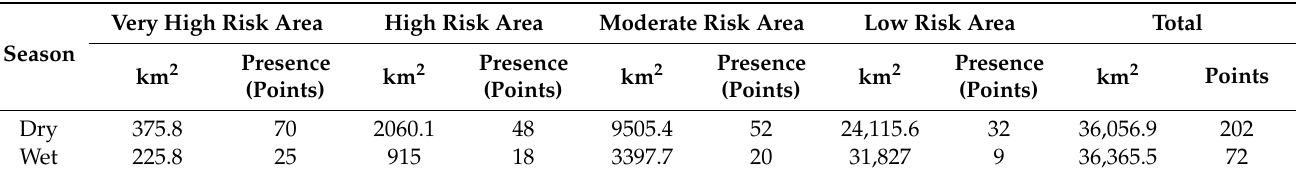
Table 1. Risk areas between human-elephant conflict in the dry season and the wet season in 2020 in the eastern part of